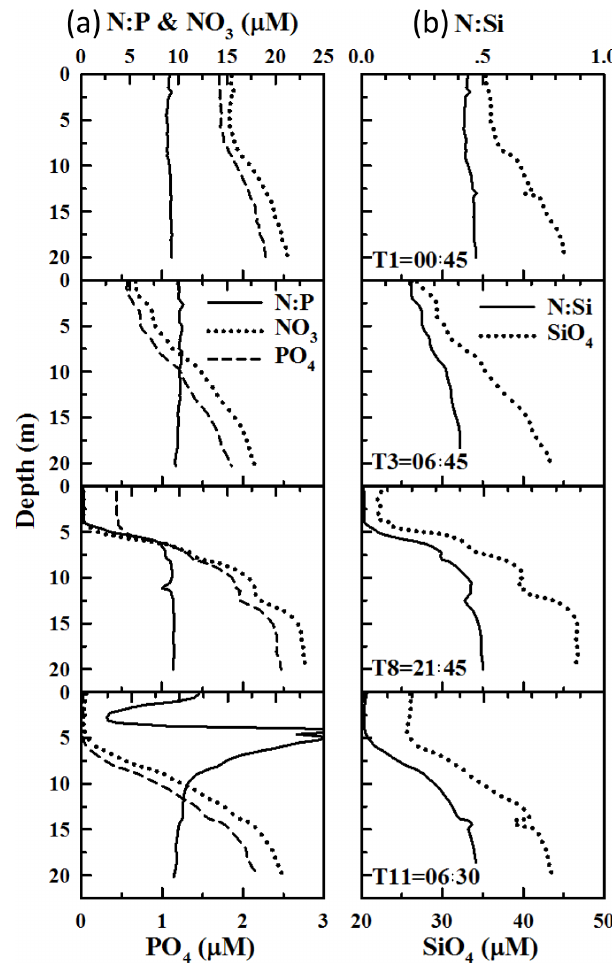
Figure 4. Vertical profiles at S3 near the Fraser River plume to P4 and P6 finally to S1, which was well beyond the plume (108km away) on 8 August 1991. (a) NO − and N:Si ratios.